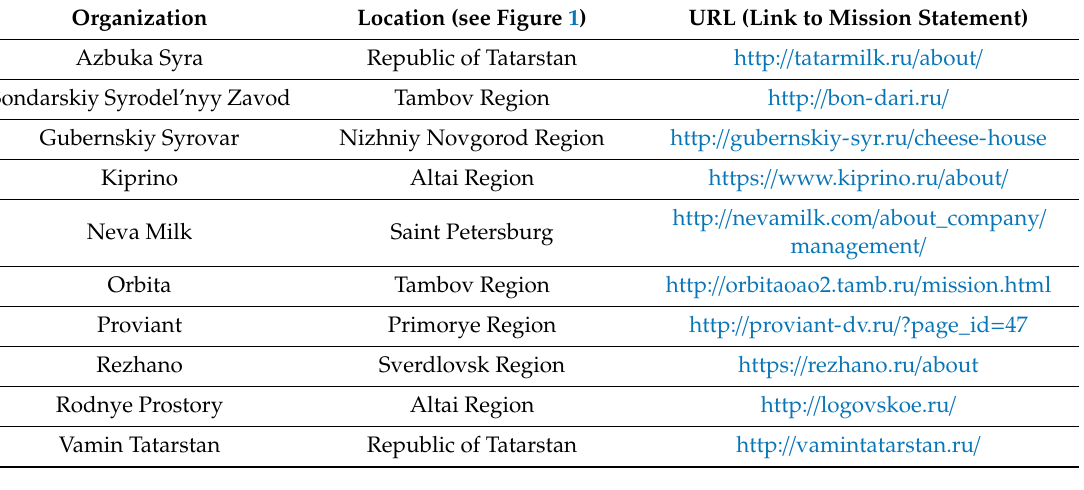
Table 1. Analyzed organizations and sources of the mission statements.